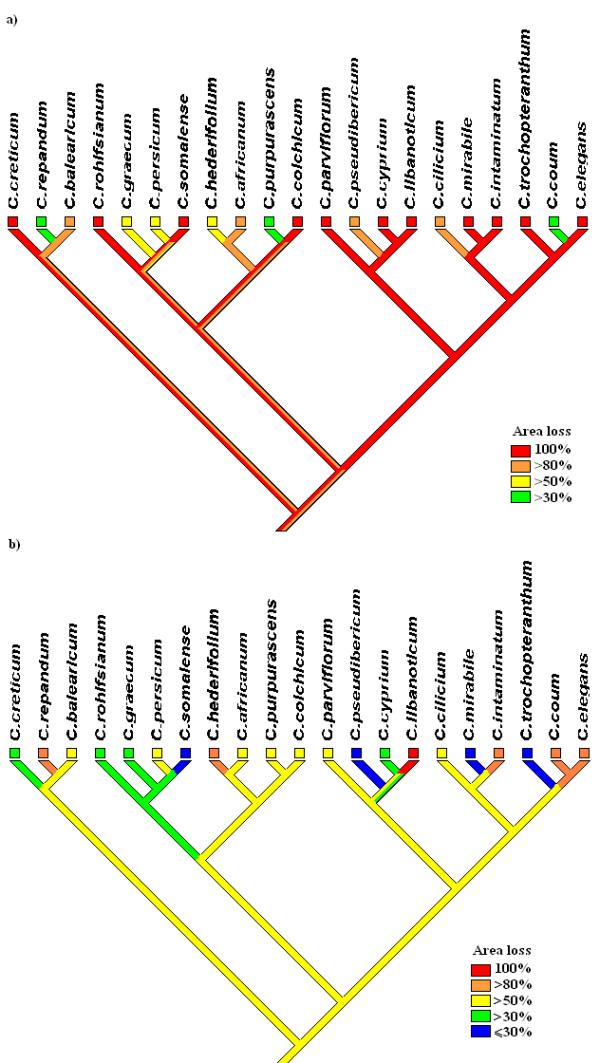
Parsimony optimisation of extinction risk for Cyclamen. Parsimony optimisation of extinction risk based on examination of models within 2050 scenario for a) BIOCLIM and b) Maxent models. Characters treated as ordered, analysis performed in Mesquite